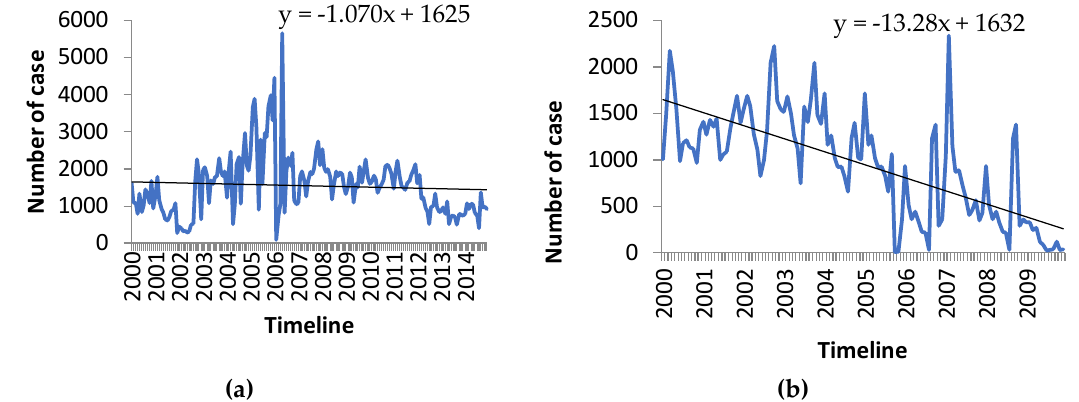
Figure 3. Observed trends of ( a ) malnutrition in the city of Antananarivo and ( b ) malaria in Morondava.